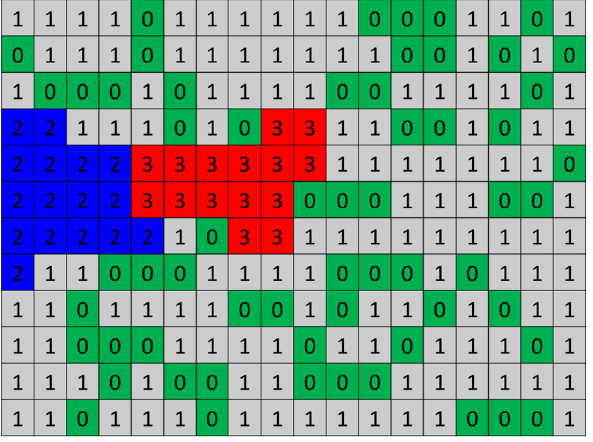
Fig 5. A sample of the solution domain with assigned numbers. 2s and 3s are two ECs, 0s are representing interstitial fluid, and 1s are matrix fibers. Matrix fibers in ECM are distributed